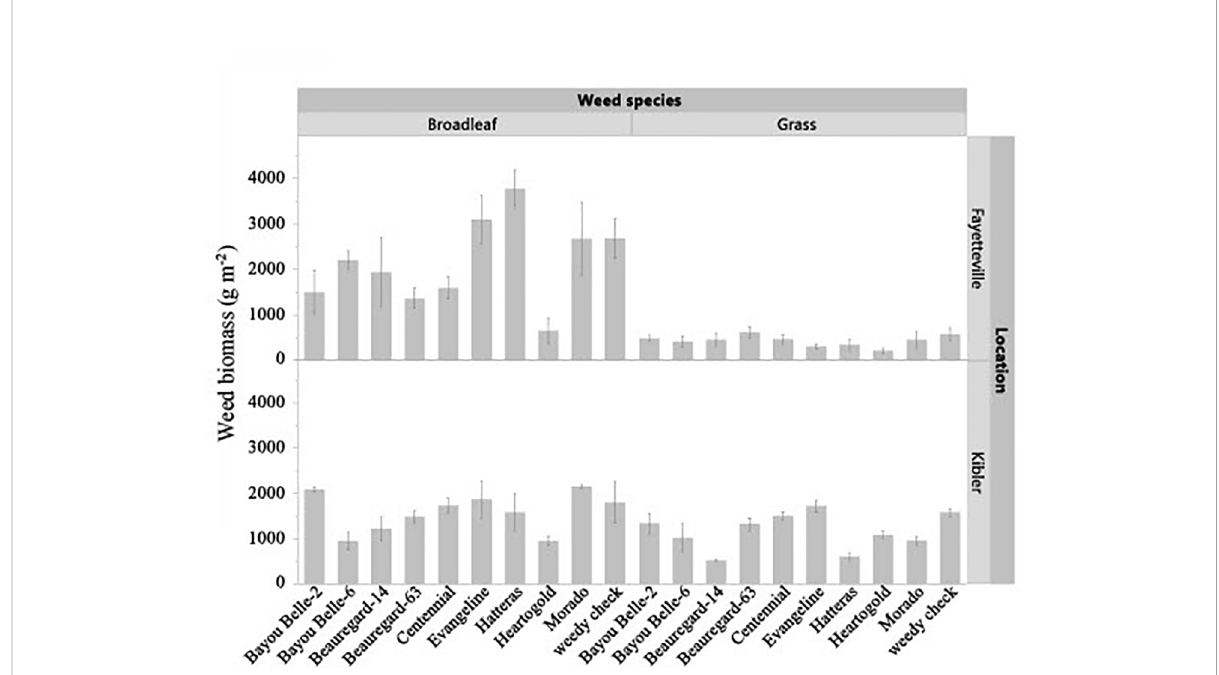
FIGURE 2 Effect of sweetpotato cultivars on broadleaf spp. and grass spp. biomass (g m -2 ) in Kibler and Fayetteville, AR, 2021. LSD to compare cultivars within location Fayetteville: 496 g m -2 . LSD to compare cultivars within location Kibler: 453 g m -2 . Bars represent standard